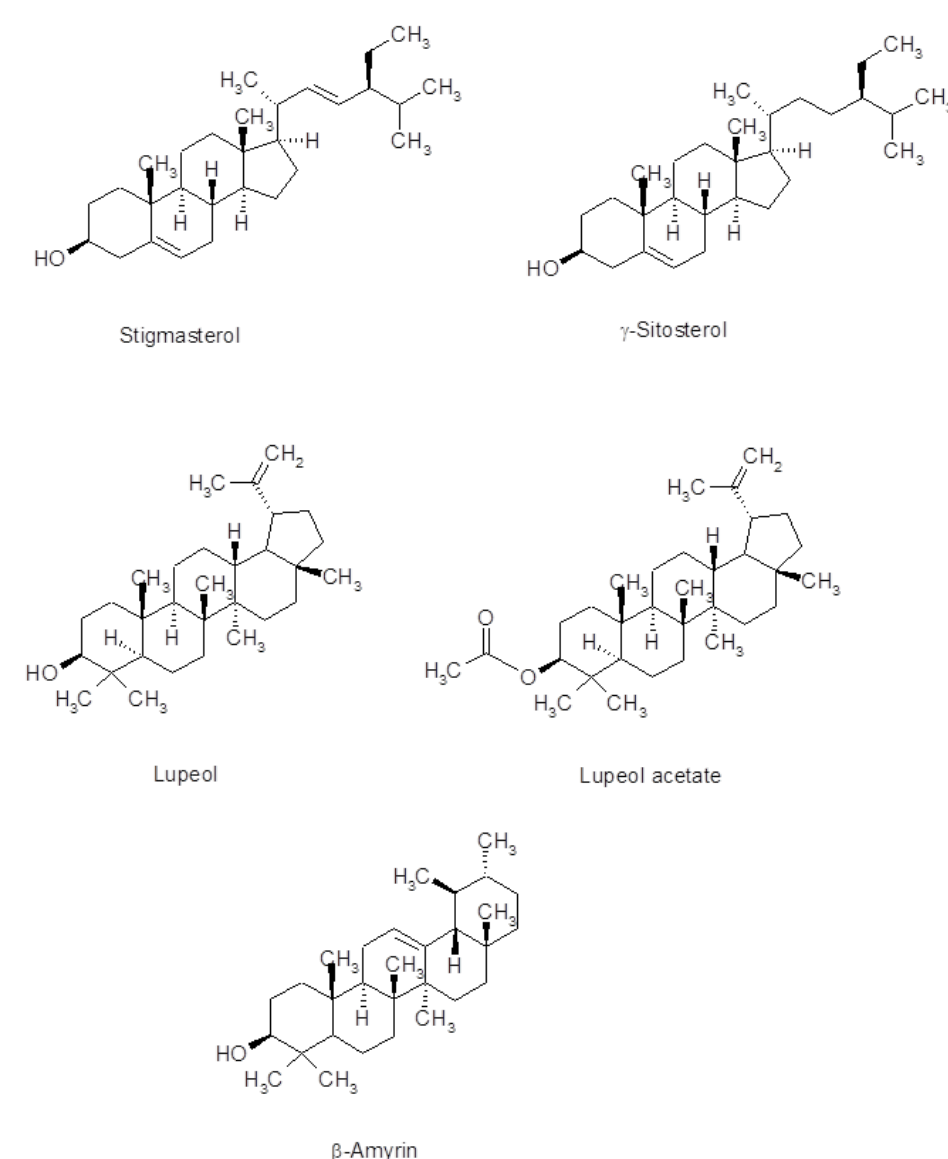
Figure 2. Phytochemicals stigmasterol, γ -sitosterol, lupeol, lupeol acetate, and beta-amyrin present in wild Scolymus maculatus extracts of methanol, ethyl acetate, and n -hexane, identified by